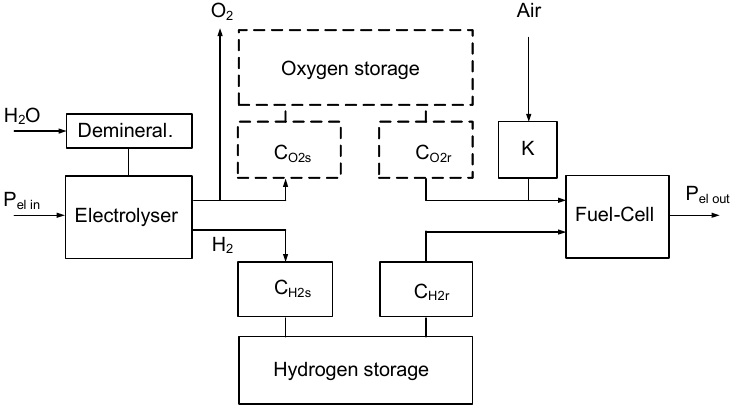
Figure 1. Simplified representation of a Hydrogen storage system.